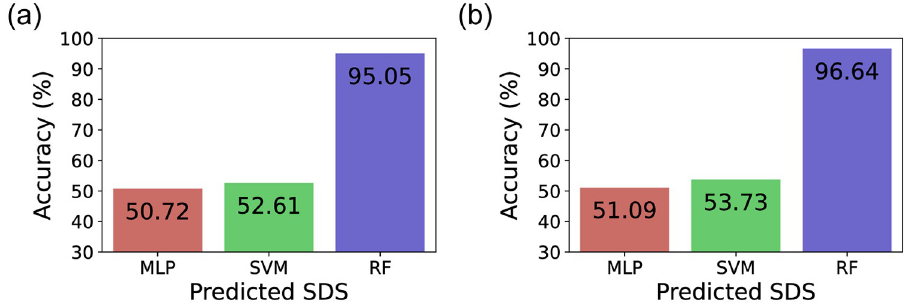
Fig 2. SDS prediction results using three models, multilayer perceptron, support vector machine, and Random Forest. For training and testing of the three models, a dataset divided into 10 bins was used for training and evaluation. (a) Left ear, (b) Right ear.